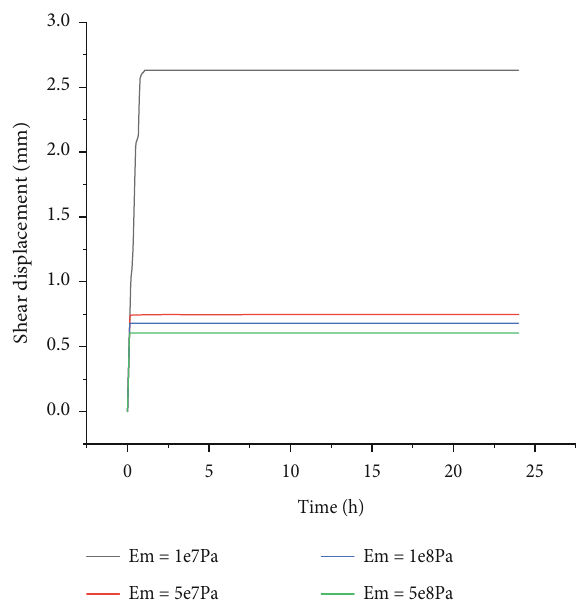
Figure 4: Shear displacement-time relation under di ff erent E bolts.